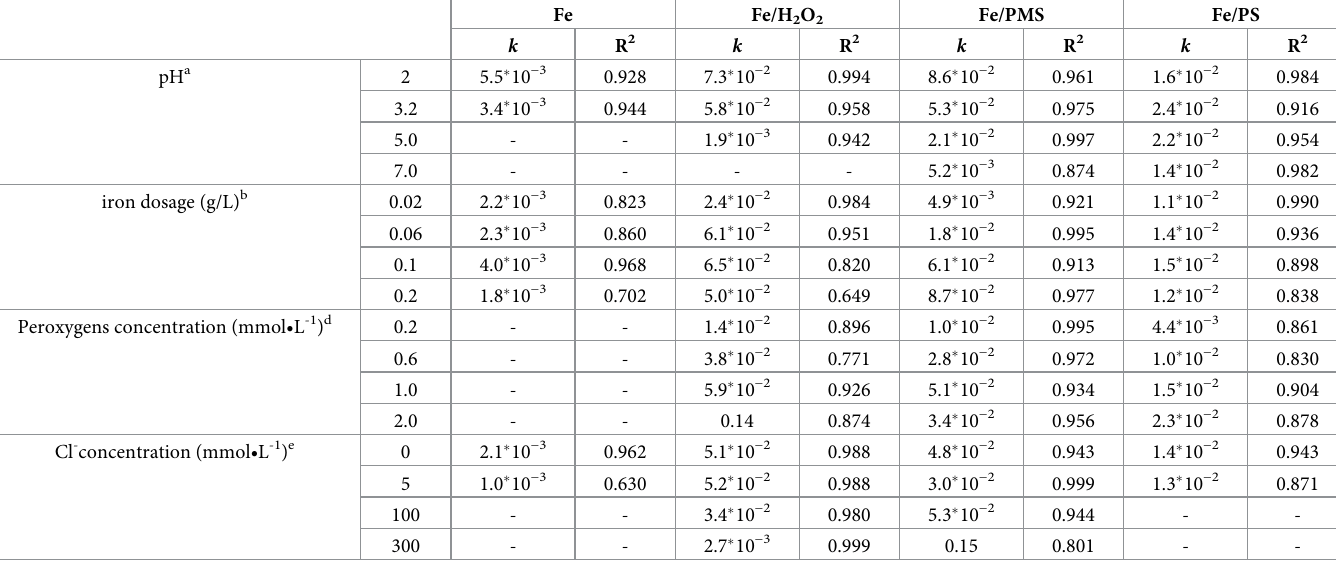
Table 1. The calculated pseudo first-order rate constant of 2,4,6-TCP degradation in Fe 0 -peroxides